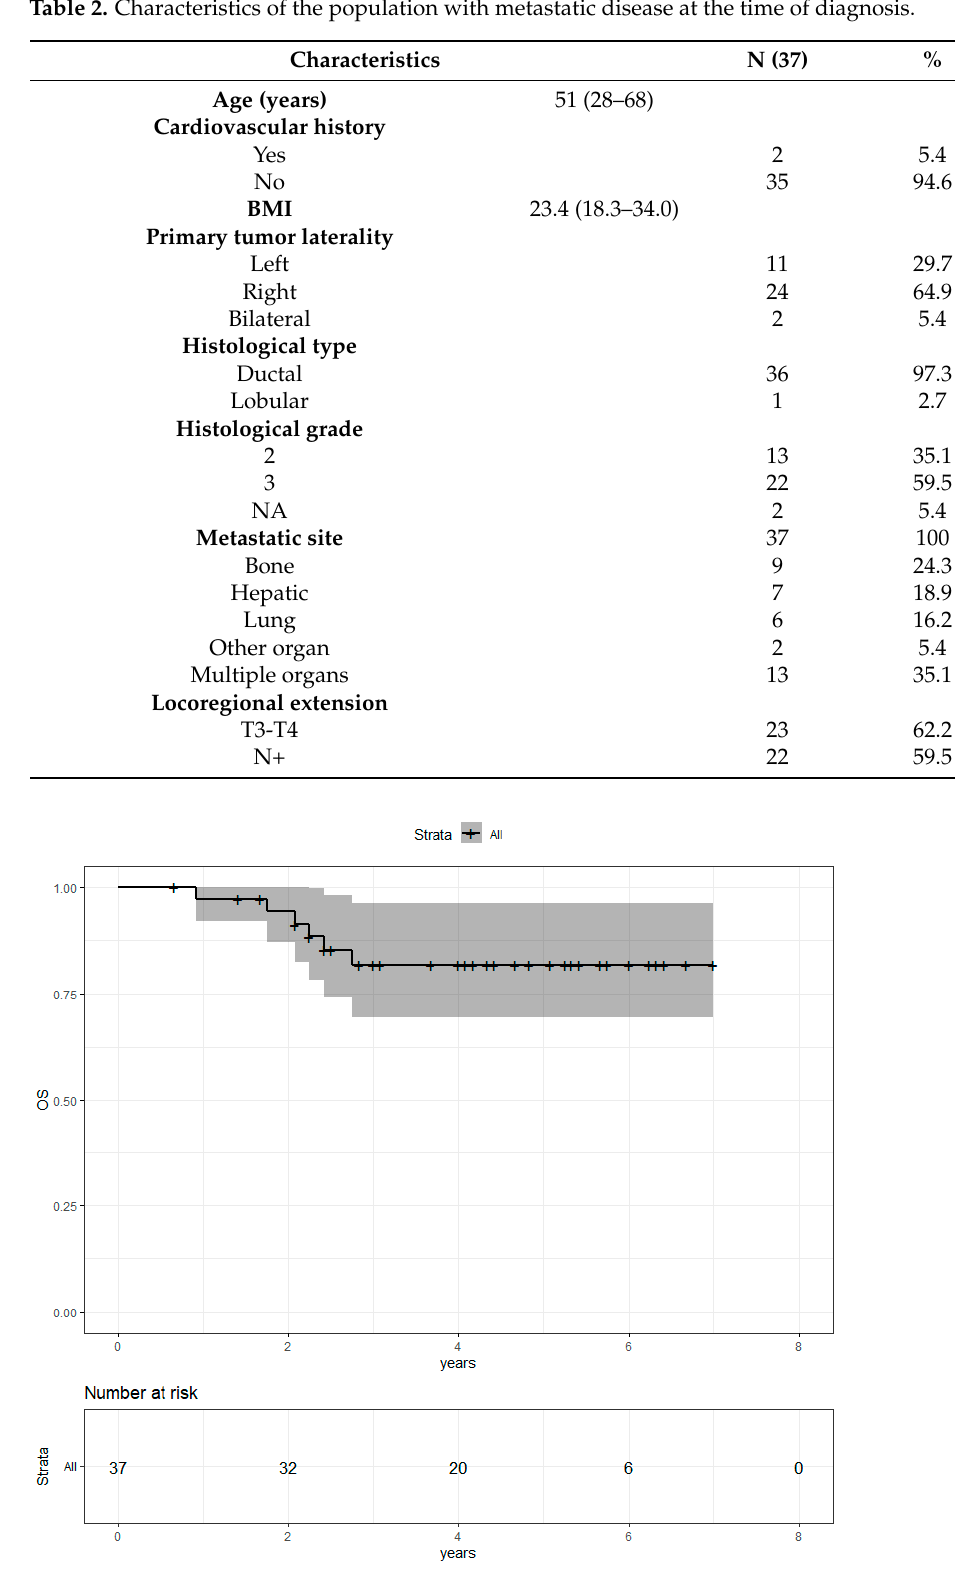
Figure 3. Progression-free survival of the population with metastatic disease at the time of diagnosis after concomitant RT and Pertu/Trastu dual HER2 blockade. Confidence intervals are provided in grey.